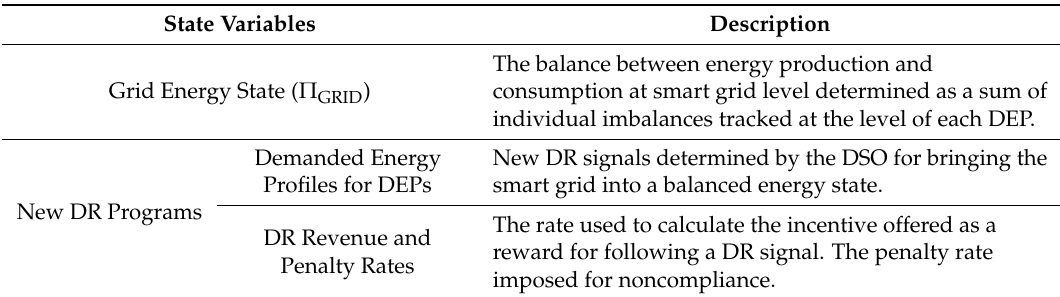
Table 3. Smart contract regulating the grid energy